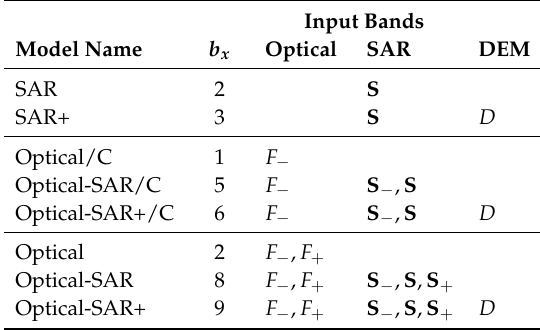
Table 2. Proposed models. The naming reflects the input stacking, explicated on the right. “SAR” refers to S1 images and “Optical” to S2 products ( F stands for